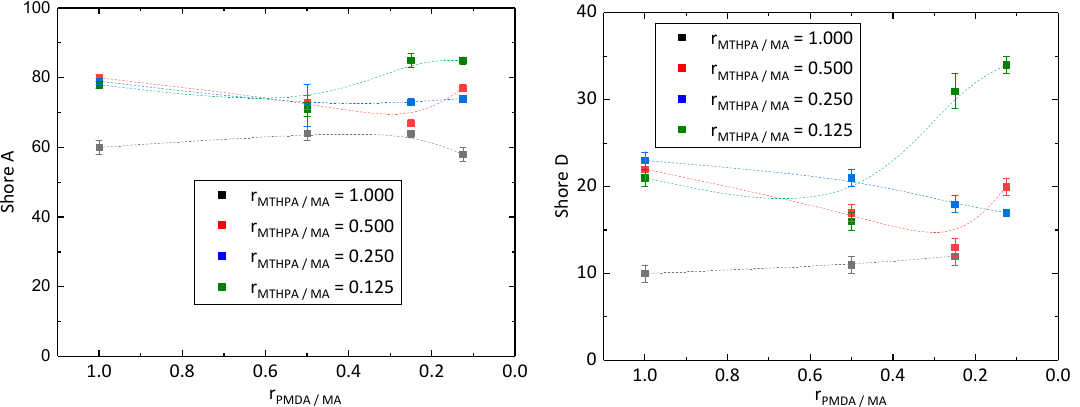
Figure 3. Shore A ( left ) and D ( right ) hardness of epoxy resins in reference to the molar ratio r PMDA/MA and r MTHPA/MA .